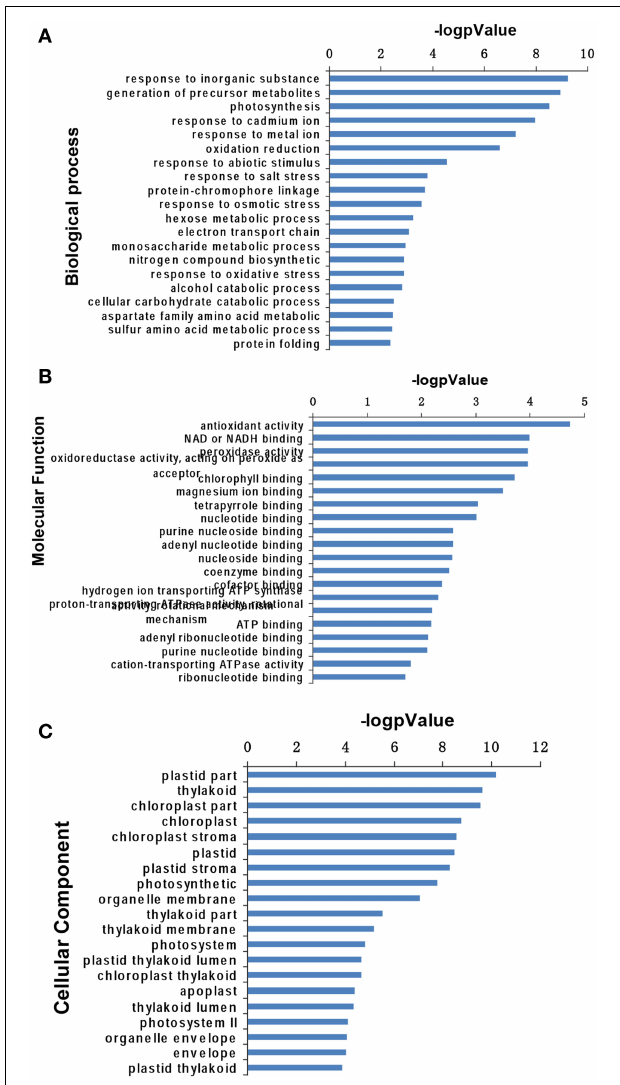
FIGURE 5 | Gene Ontology analysis of salinity stress-responsive proteins in the leaves of T. Nitraria seedlings. Expressed proteins involved in biological process (A) , molecular function (B) , and cellular component (C) against the GO